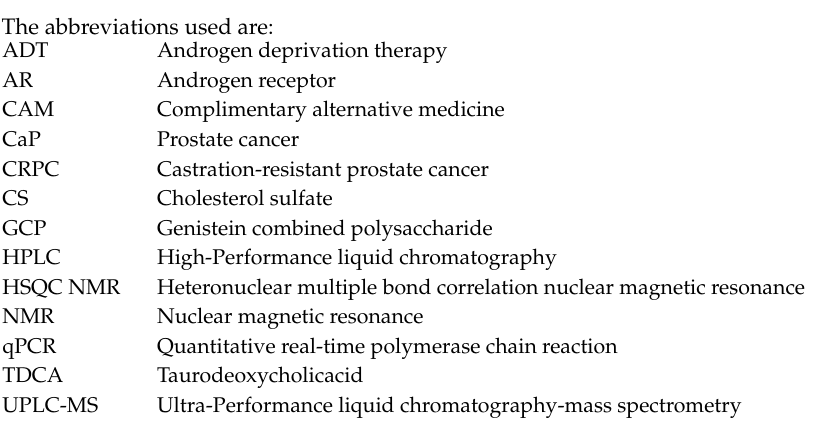
Figure S1: Reverse Phase HPLC analysis of GCP, Figure S2: 1D 1 H NMR analysis, Figure S3: 2D 1 H- 13 C HSQC NMR analysis of fraction 37, Figure S4: 2D 1 H- 13 C HSQC NMR analysis of fraction 40, Figure S5: 2D 1 H- 13 C HSQC NMR analysis of genistein, Figure S6: 2D 1 H- 13 C HSQC NMR analysis of glycitein, Figure S7: 2D 1 H- 13 C HSQC NMR analysis of daidzein, Figure S8: Western blot